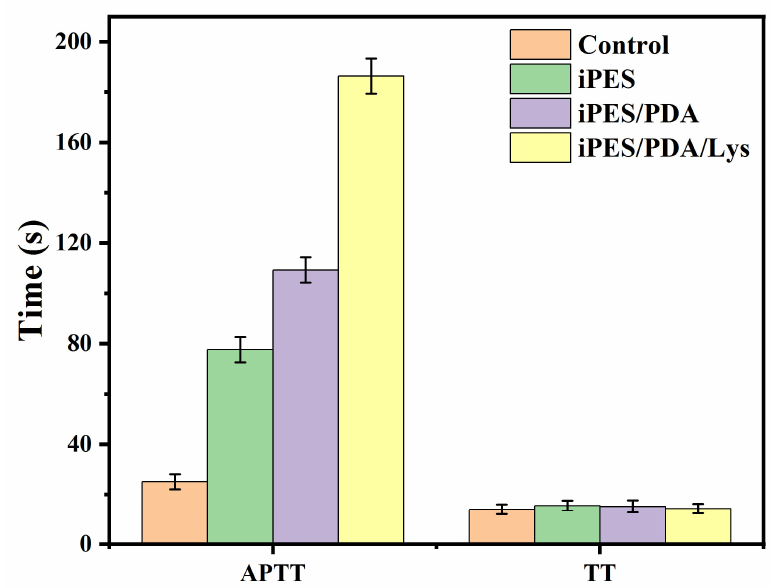
Figure 5. APTT and TT assays for the iPES, iPES/PDA and iPES/PDA/Lys membranes. The results are expressed as means ± SD (n = 3).